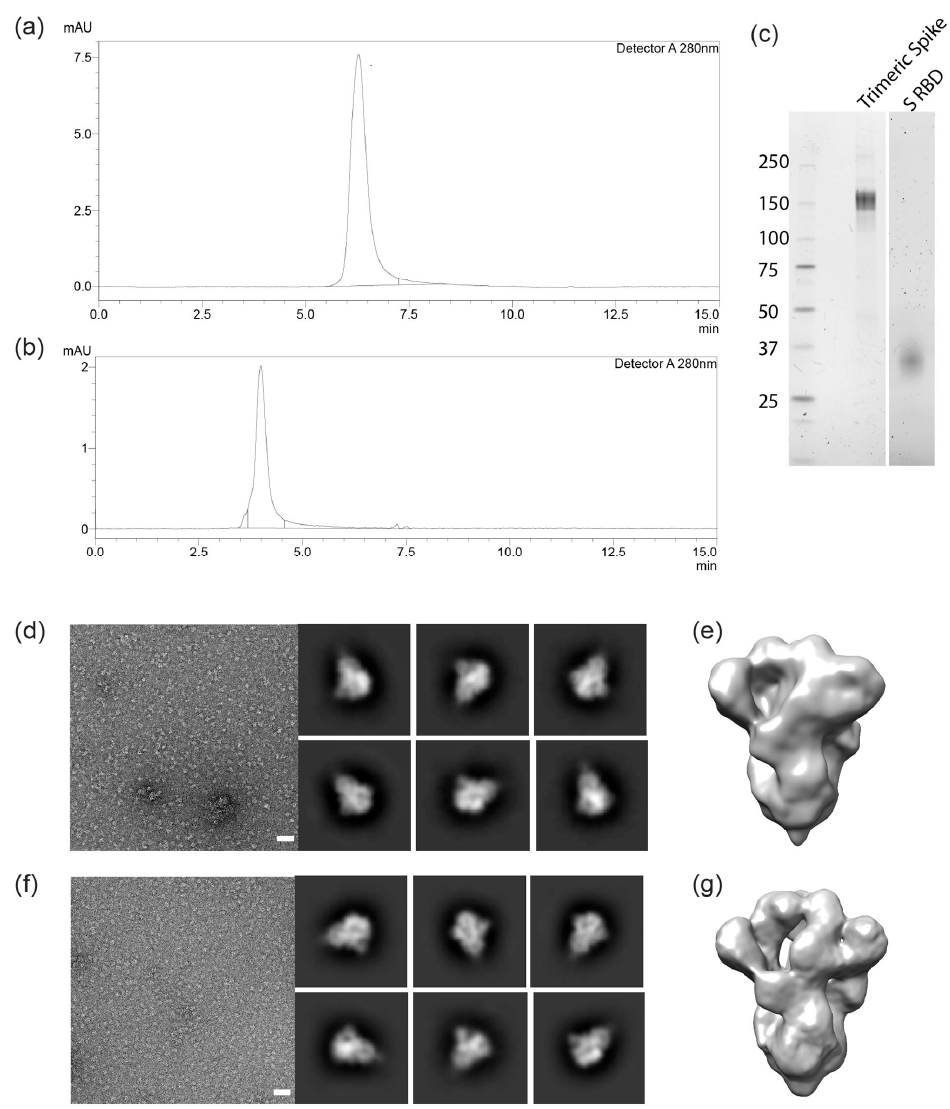
Figure 3. Characterization of the recombinant trimeric spike and RBD. ( a , b ): Size-exclusion chromatography (SEC) analysis plot with a single peak at 4.0 and 6.4 min for trimeric spike and RBD, respectively. SDS-PAGE gel showing bands for trimeric spike ( c ) and for RBD monomer ( d ). Negative-stain electron microscopy of the SARS-CoV-2 trimeric spike of the Wuhan strain ( d , e ) and for the D614G variant of the virus ( f , g ). White bars in d and f: 50 nm. Six 2-D class averages are shown to the right of each representative micrograph. 3-D reconstructions are shown in ( e , g ).